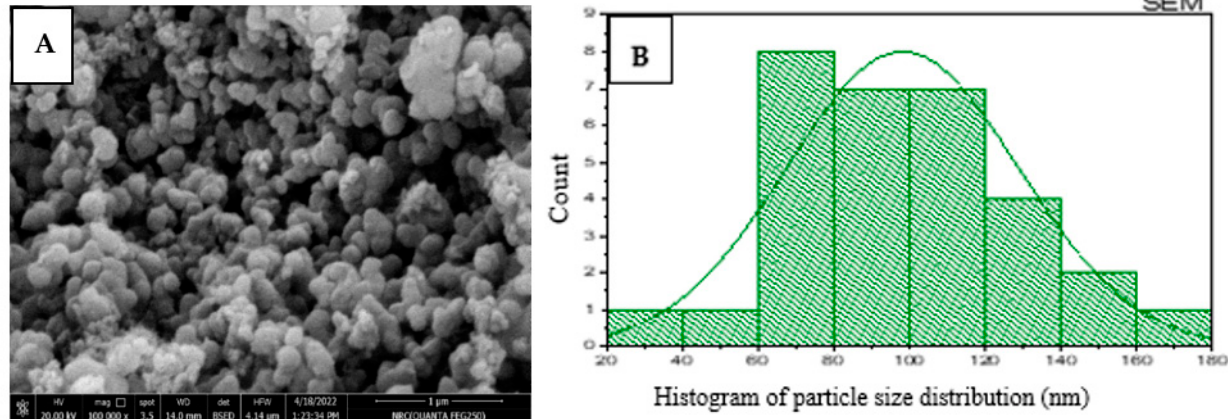
Figure 5. SEM image of Qi-ZnO-NPs ( A ) and particles size distribution histogram ( B ).